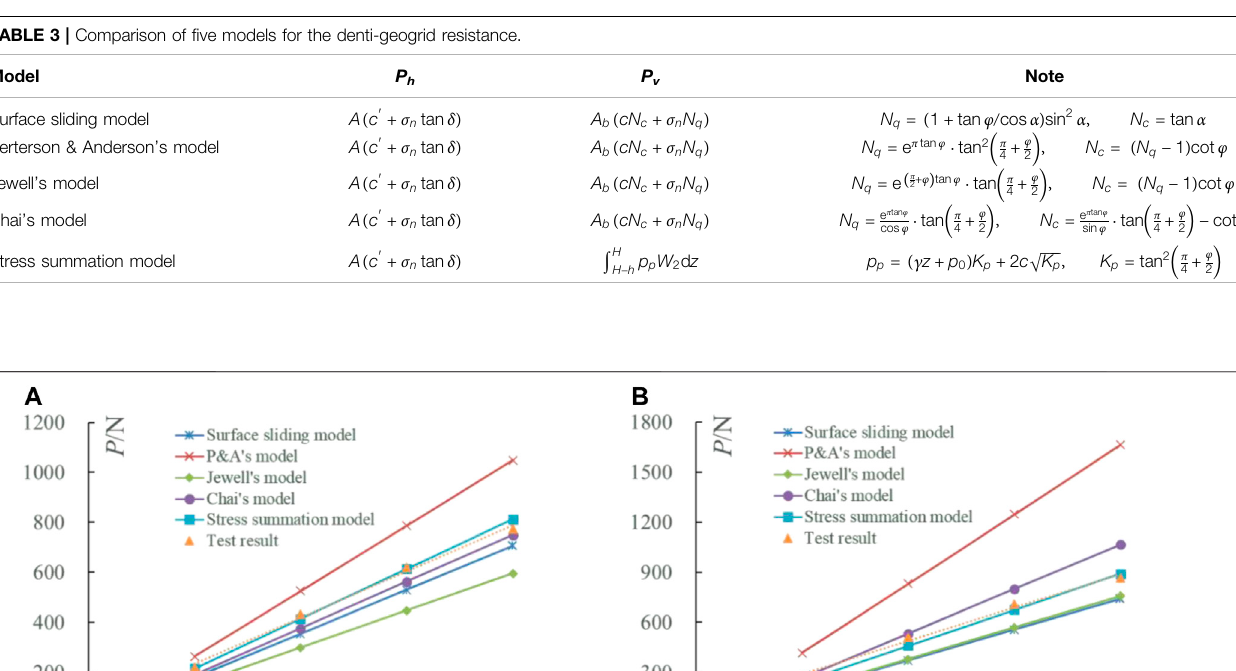
f 2 showed a uniform distribution over the surface of wedge block. According to Mohr stress circle, the angle between the slip surface and themajorprincipalstressplane (i.e.,theapexangle ofthe wedgeblock) was speci fi ed to be: α (cid:2) π /4+ φ /2.